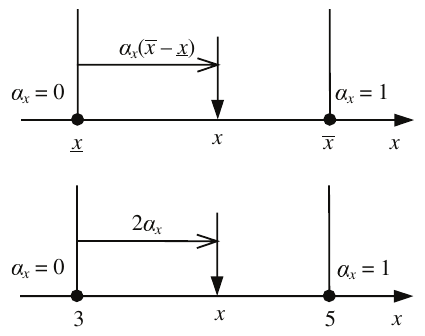
Fig. 2. Illustration of the meaning of the RDM-variable α x in the case of a normal interval [ x , x ] , x > x